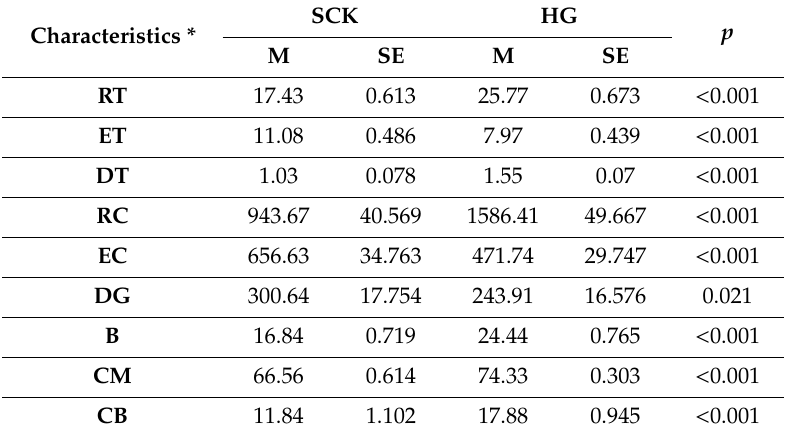
Table 2. Results of RumiWatch noseband sensor readings of dairy cows that were eventually diagnosed with subclinical ketosis and cows that remained healthy in 2020 at Lithuania. Means (M) and standard errors (SE) by groups of